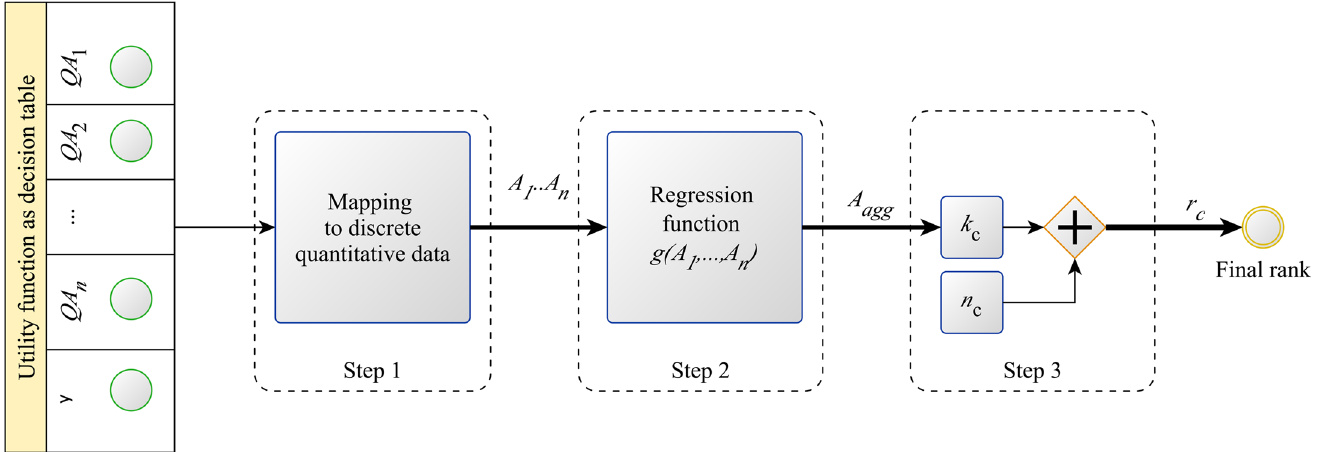
Fig 2. Workflow describing the transformation process from qualitative attributes and quantitative features to final quantitative evaluation.